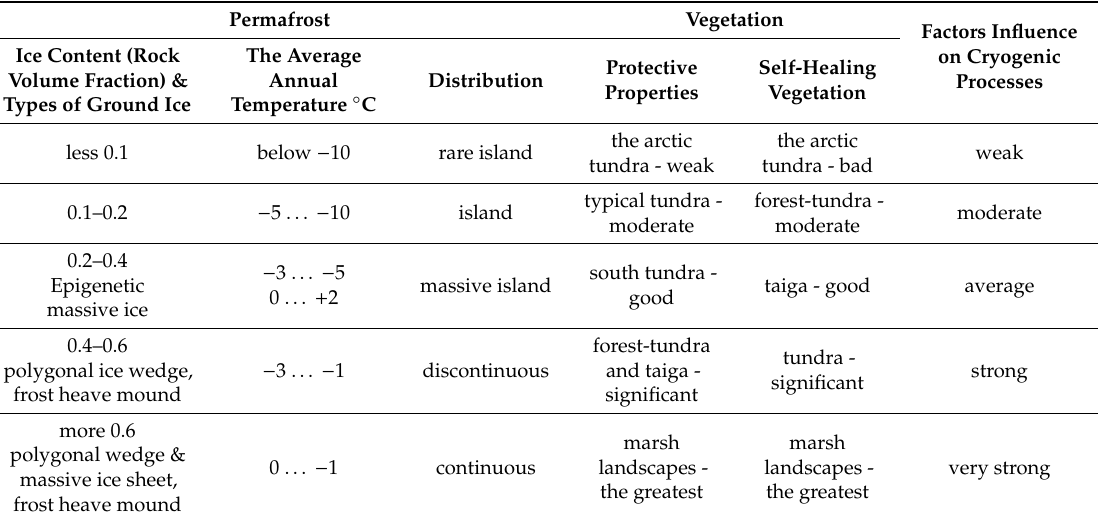
Table 1. The main factors intensifying cryogenic processes.